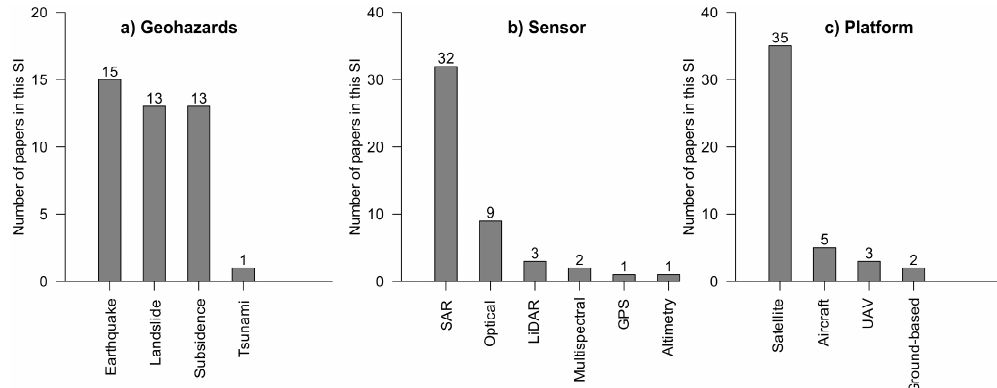
Figure 2. Number of papers published in this Special Issue (SI) classified according to: ( a ) the types of geohazards; ( b ) the types of sensors employed; and ( c ) the types of the sensor platforms. Note that (i) the total number in ( a ) is less than 43 since one article addresses an EO method that could be applied to various geohazards; and (ii) the total numbers in ( b , c ) are greater than 43 because multiple sensors and/or platforms were utilised in some papers.